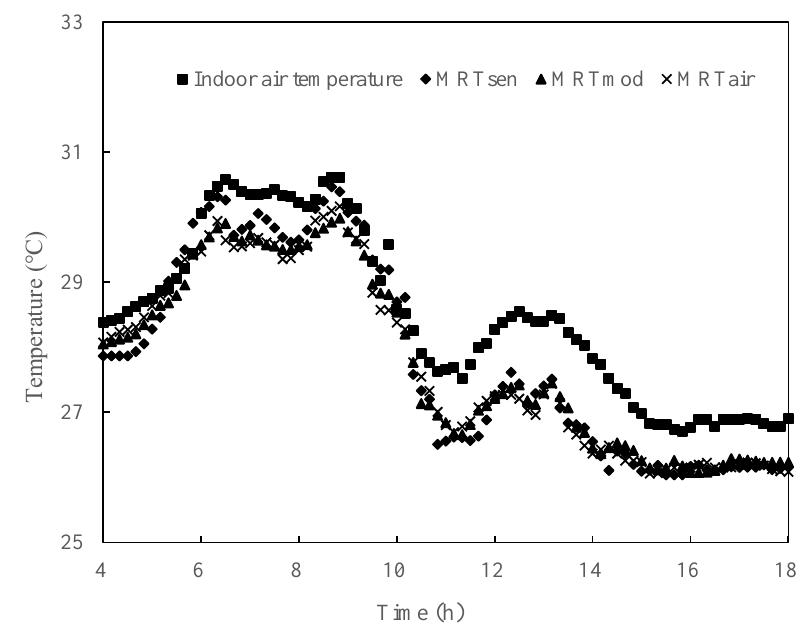
Figure 19. Comparison of the results obtained by the three MRT calculation methods.